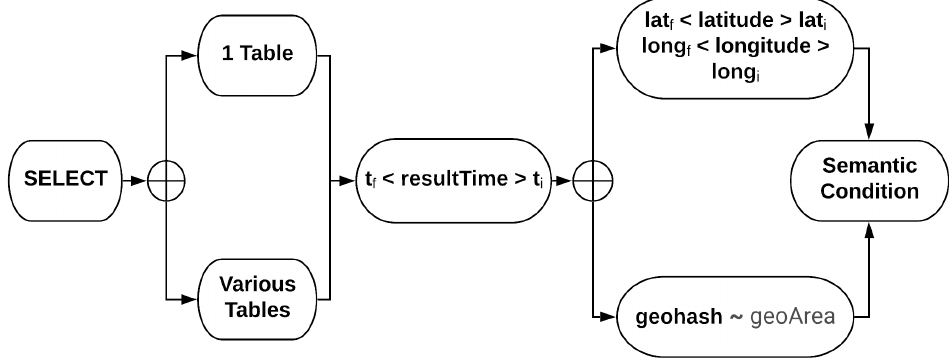
Figure 3. Spatio-Temporal Semantic Query definition. Query parameters ( t i , t f , lat i , lat f , long i , long f , geoArea ) ( t i = Initial time, t f = Final time, lat i = minimum latitude, lat f = maximum latitude, long i = minimum longitude, long f = maximum longitude, geoArea = Circumscribed bounding box defined through low precision geohash